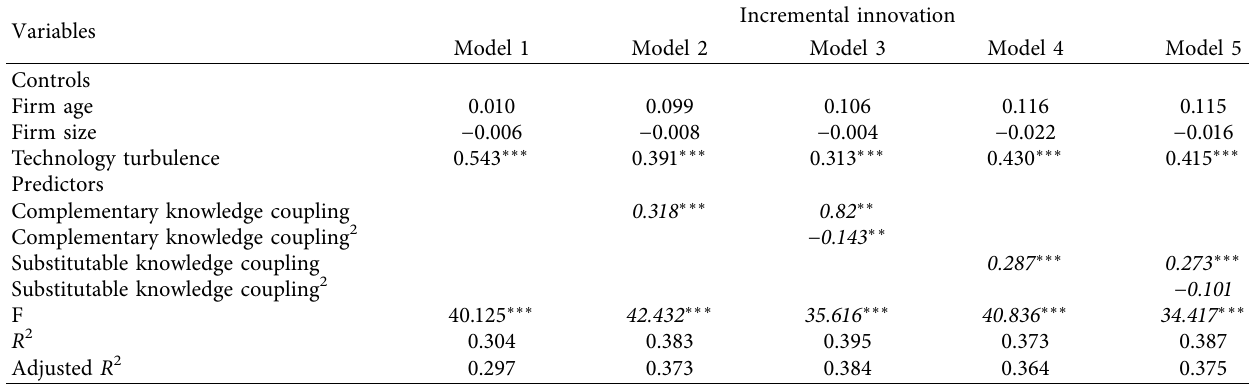
Table 3: Test of direct effect of knowledge coupling on firms’ incremental innovation.